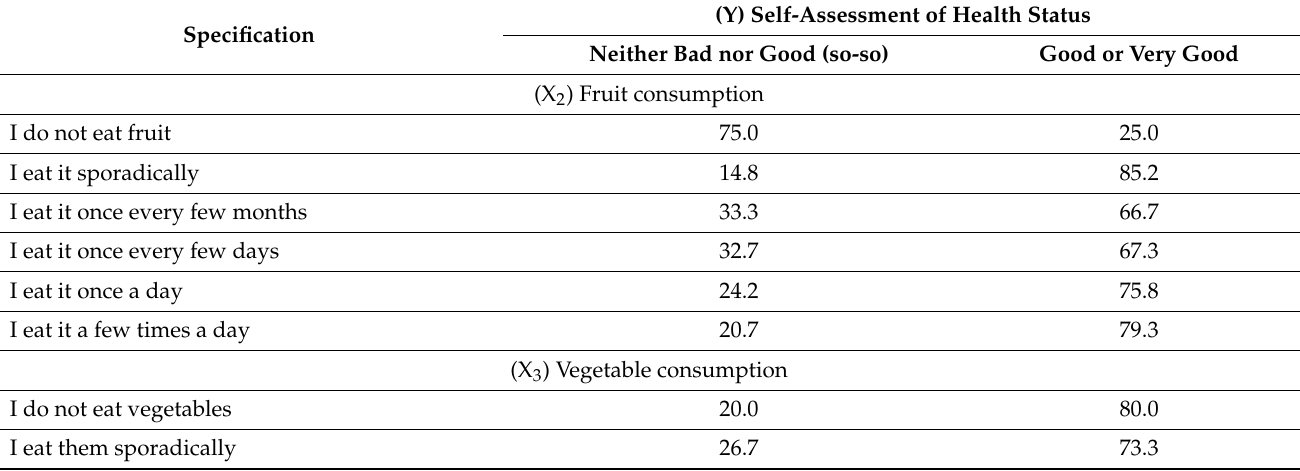
Table 3. Self-assessment of health status and selected food